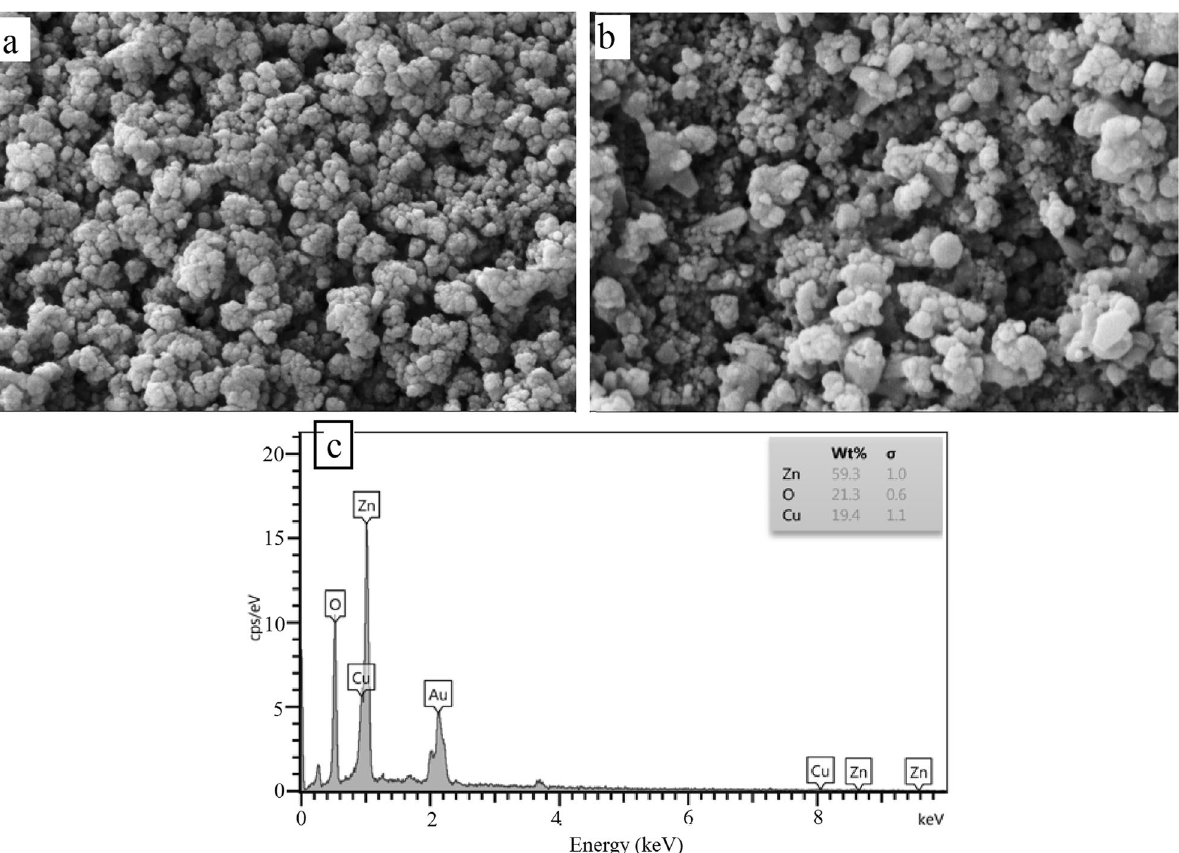
Figure 2. SEM images ( a, b ) and EDX spectra ( c ) of the ZnO/CuO